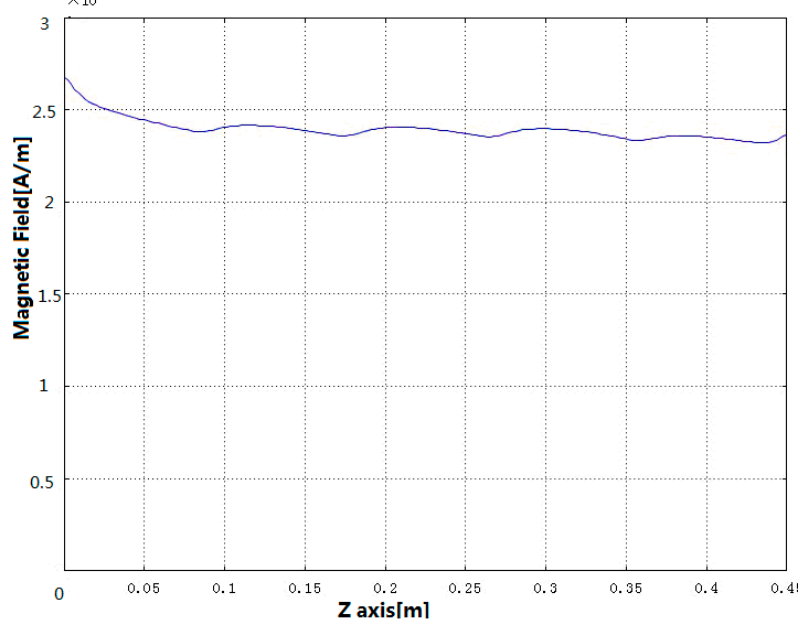
Figure 5. The distribution of magnetic field in the center axis of GMM rod.